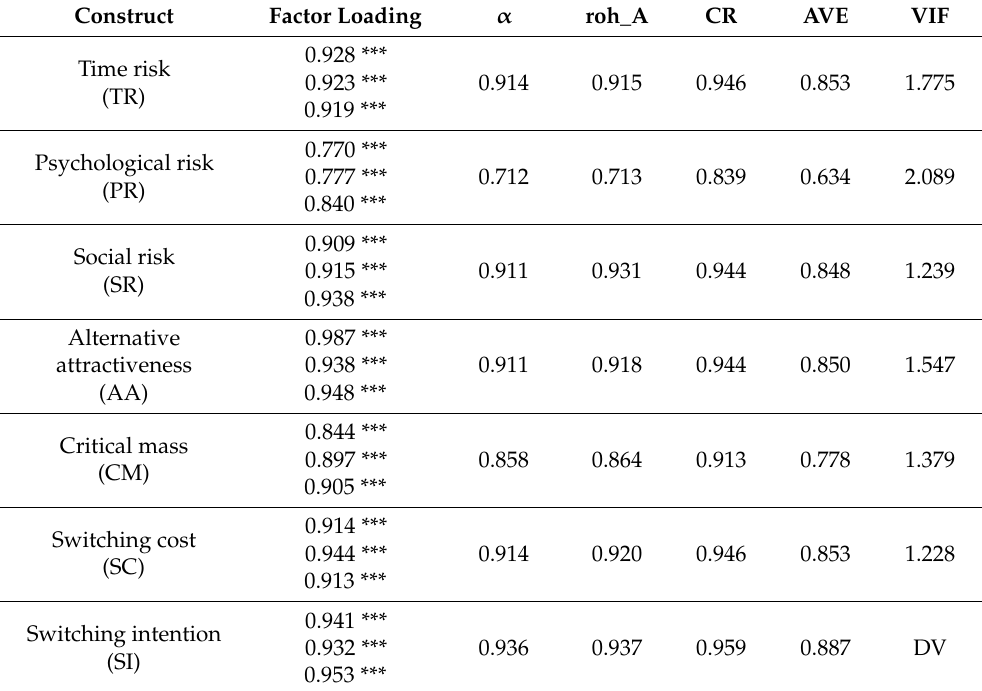
Table 1. Results of reliability and convergent validity of measurement model.